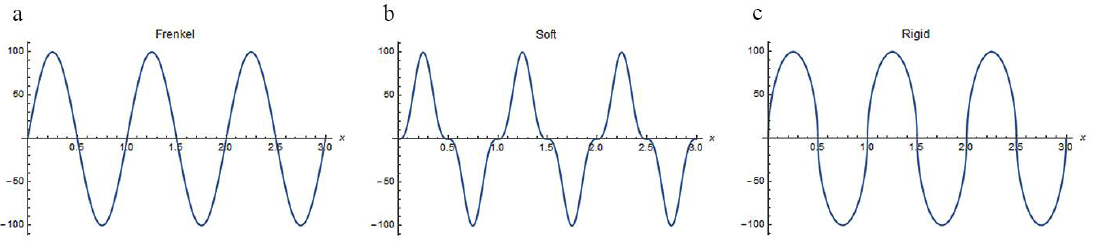
Figure 8. Periodic functions τ with different slopes μ at the points τ = 0. ( a ) Sinusoidal function, μ = 1; ( b ) soft function, μ = 0; ( c ) infinitely rigid function, μ = ∞.